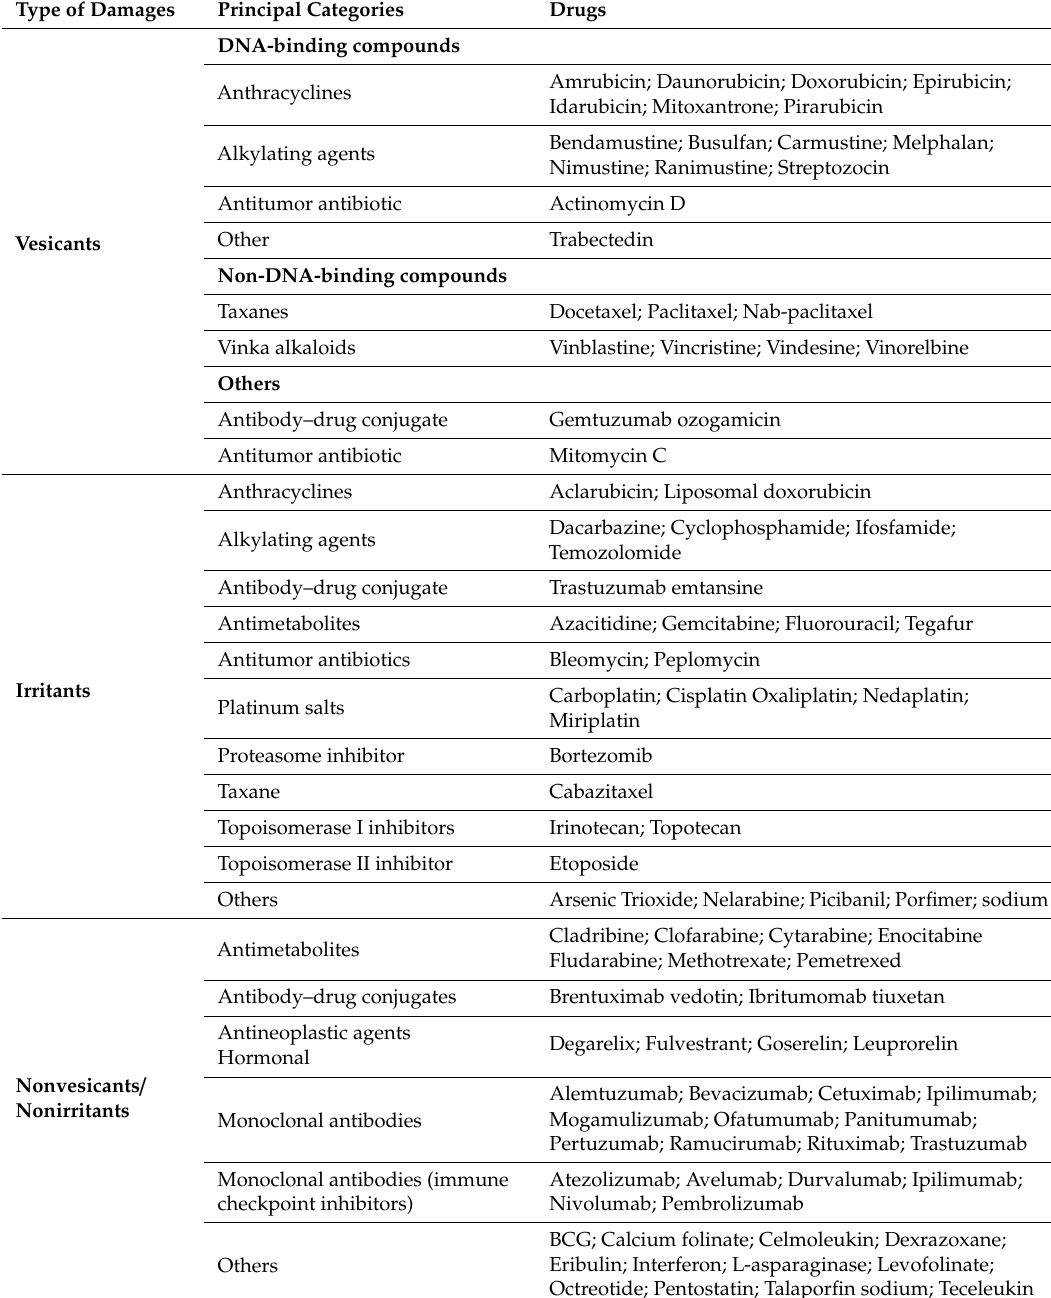
Table 2. Classification of chemotherapeutic drugs according to tissue damage after